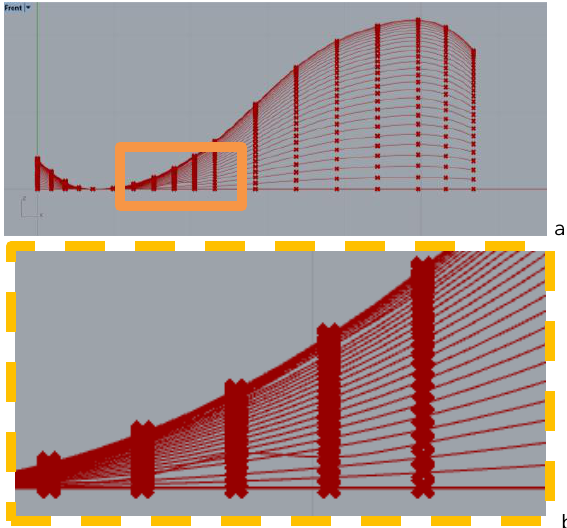
Figure 8: The Grasshopper© algorithm of the overlaying of transverse sections of the gaussian vaults of the Seaport Deposit of Montevideo, designed and built by Eladio Dieste in 1979, in Montevideo, Uruguay. This algorithm reveals mistakes in the transcription of values from the calculations to the ‘geometry of the vault’